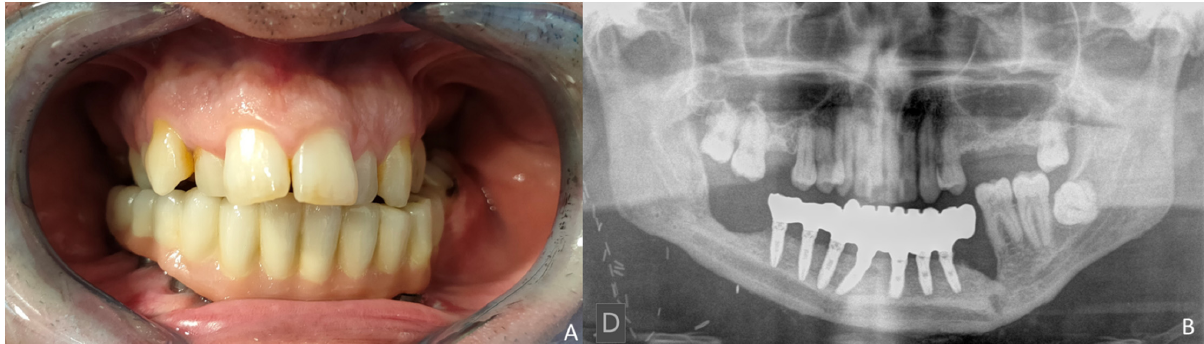
Figure 11. Functional result. ( A ) Final dental restoration. ( B ) Panoramic radiograph demonstrating the reconstruction of the previous height of the mandible with a correct osseointegration of the implants.